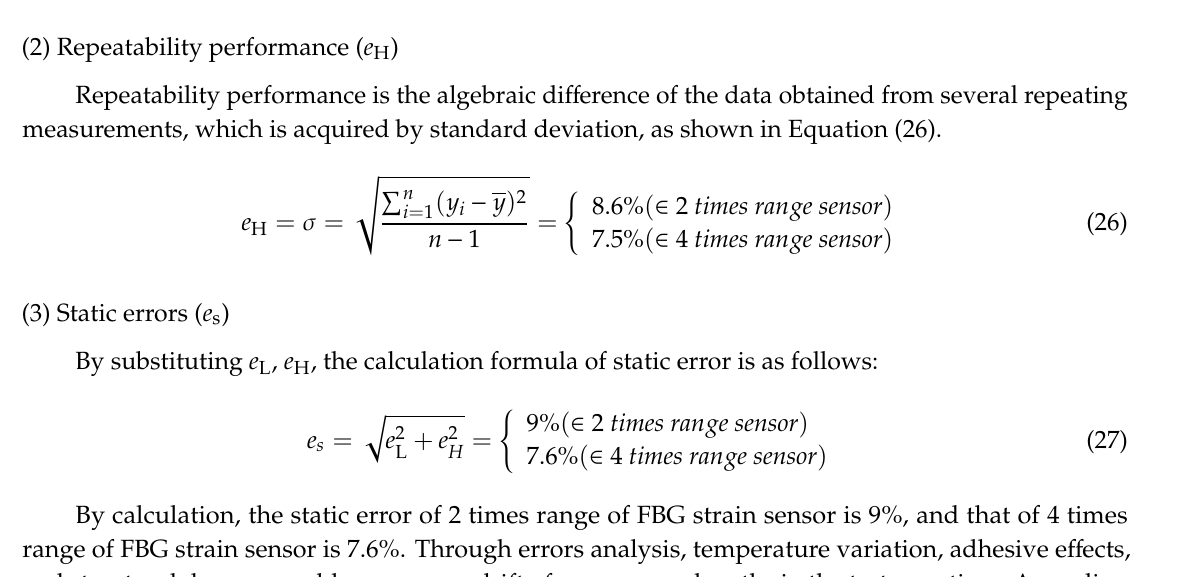
Figure 12. Calibration of 4 times range